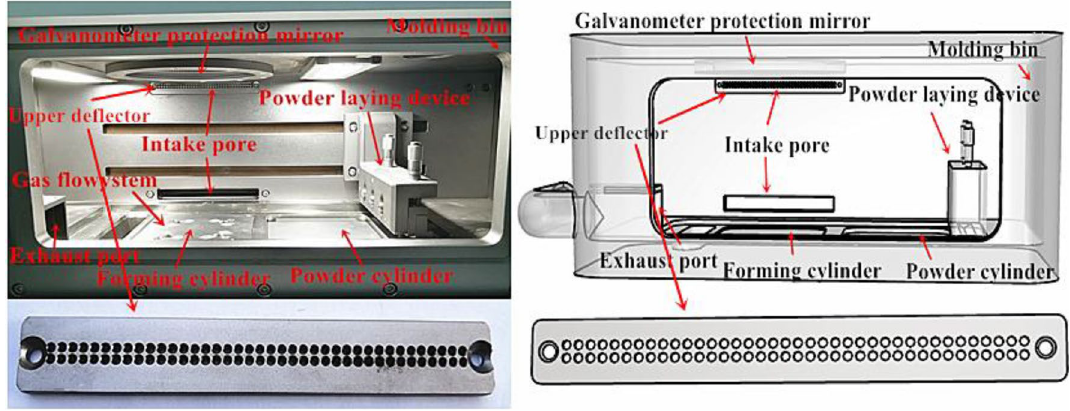
Figure 2. SLM forming device structural representation.